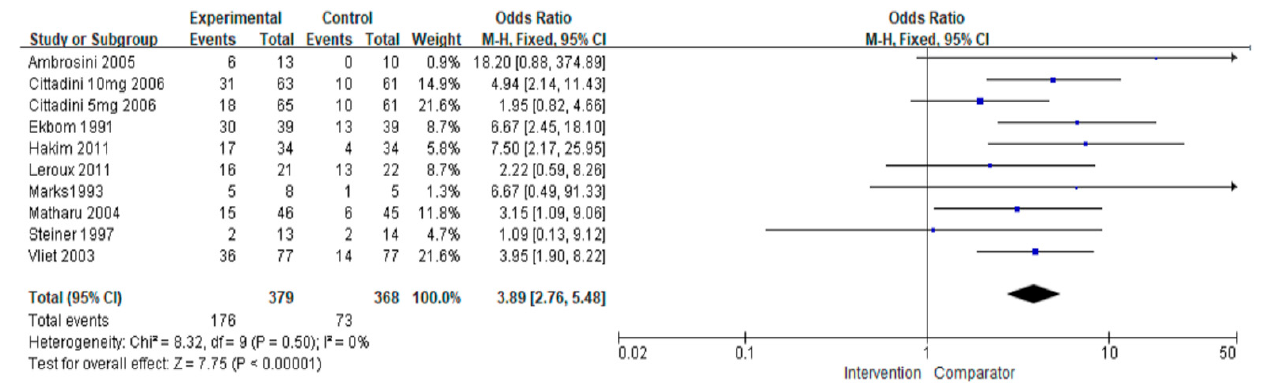
Figure 5. The overall effect of pharmacological treatment on pain-free rate compared to placebo. Blue squares indicated effect size for each of included studies and the size of blue square indicates the weight assigned to that study in the meta-analysis. Black diamond suggested as meta-analyzed measure of effect. Bold letters represented a category or subtotal of overall outcome.